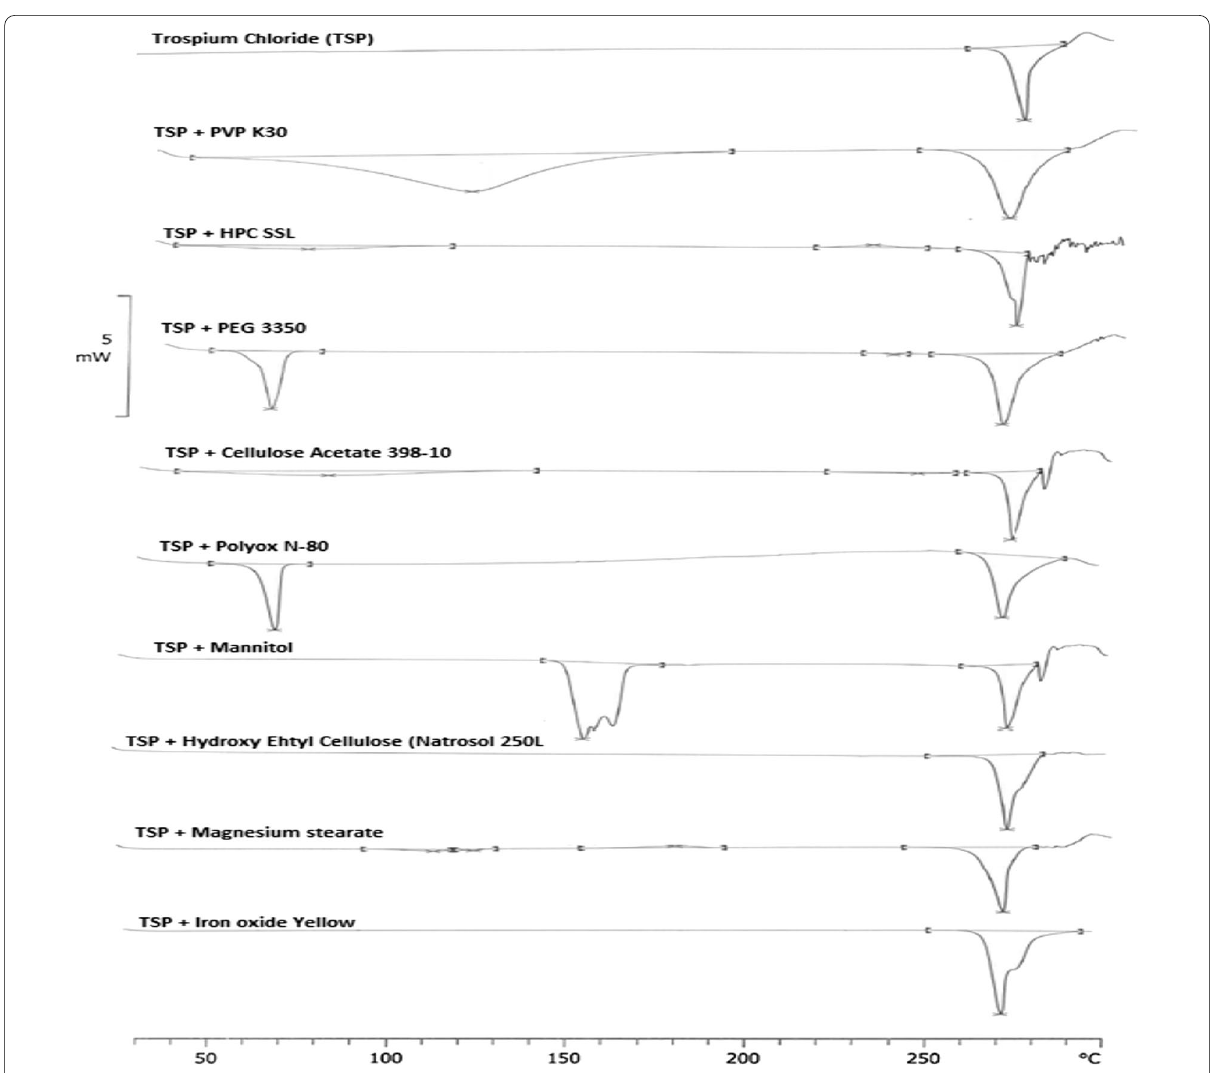
Fig. 1 DSC thermograms of the pure drug and physical mixtures of drug and excipients